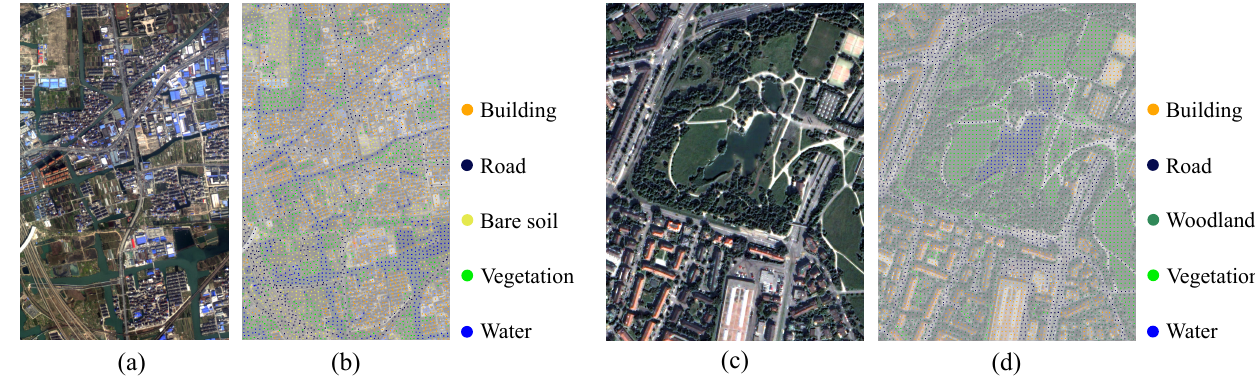
Figure 5. Original images and corresponding samples. ( a , c ) are the Gaofen-2 and QuickBird images, respectively. ( b , d ) are the samples selected from the original images for